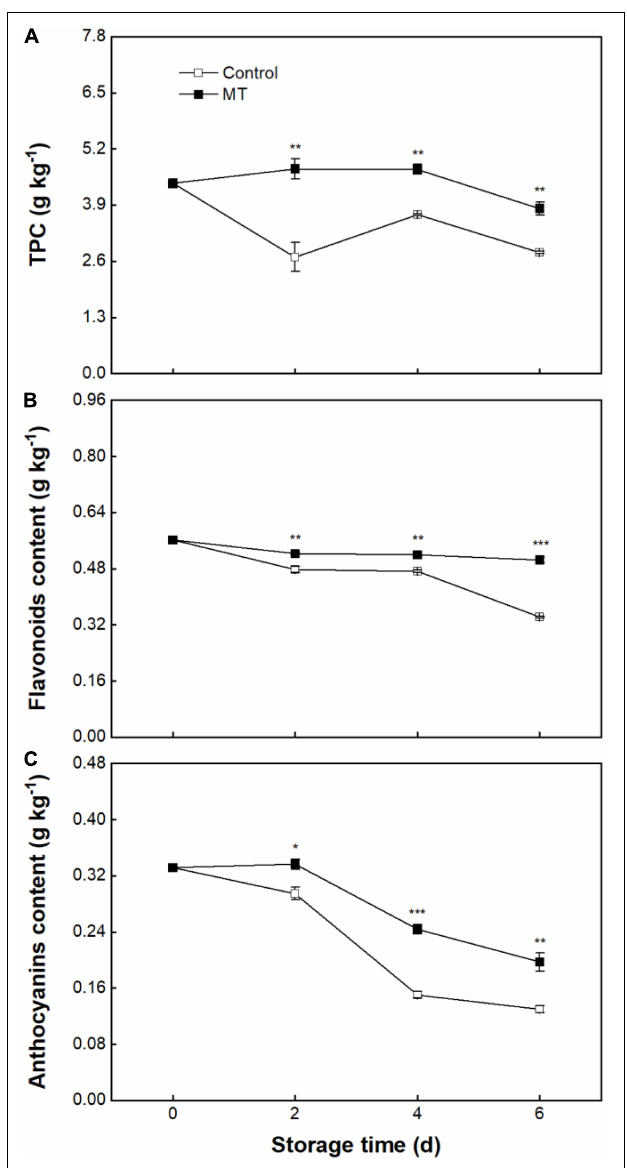
FIGURE 5 | Total phenolic content (TPC) (A) , flavonoids content (B) , and anthocyanins content (C) in “Baoyan 7” rambutan fruit during storage at 25 ◦ C after treatment with 0.125 mmol L − 1 MT or water (control). The vertical lines represent the SE of triplicates while the asterisks indicate a significant difference between the MT group and the control group on the same day (* p < 0.05, ** p < 0.01, and *** p < 0.001).